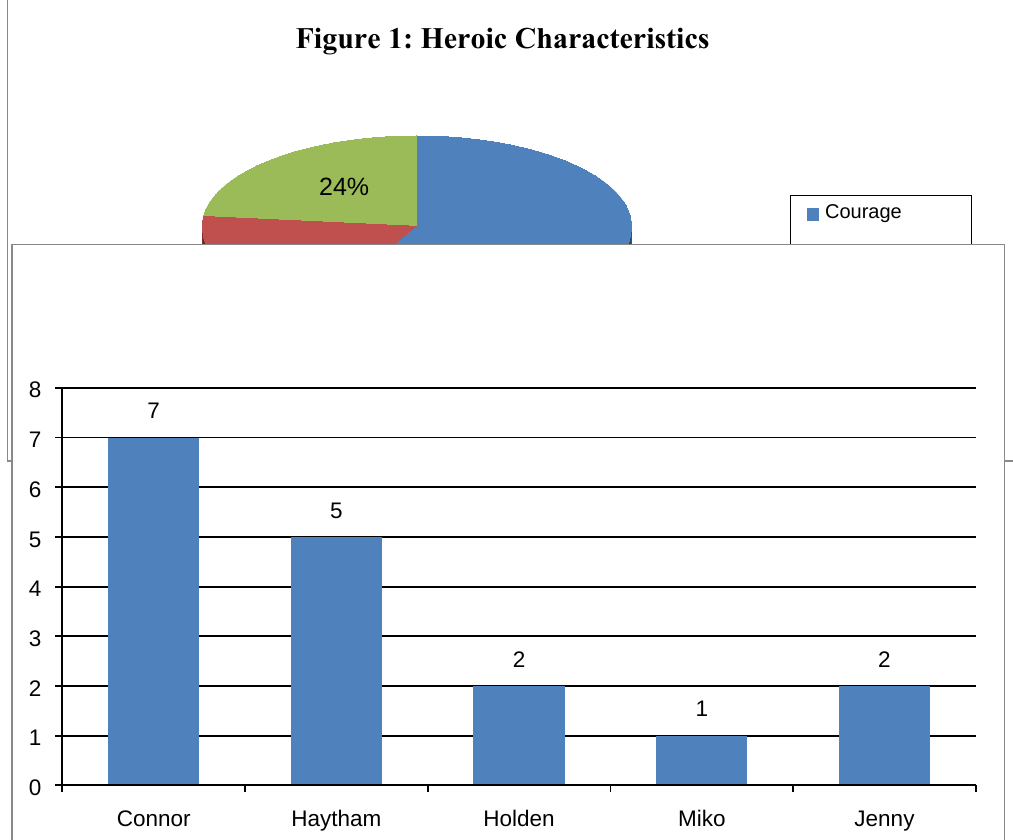
Figure 1: Heroic